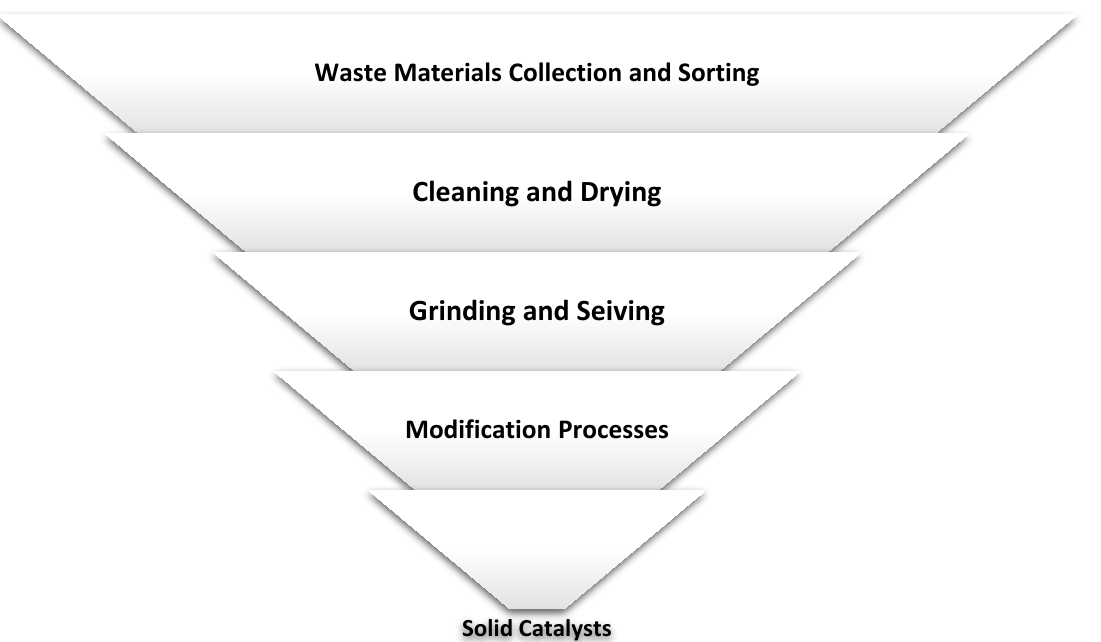
Figure 2. Generic synthesis method for transforming agricultural wastes into a solid catalysts.